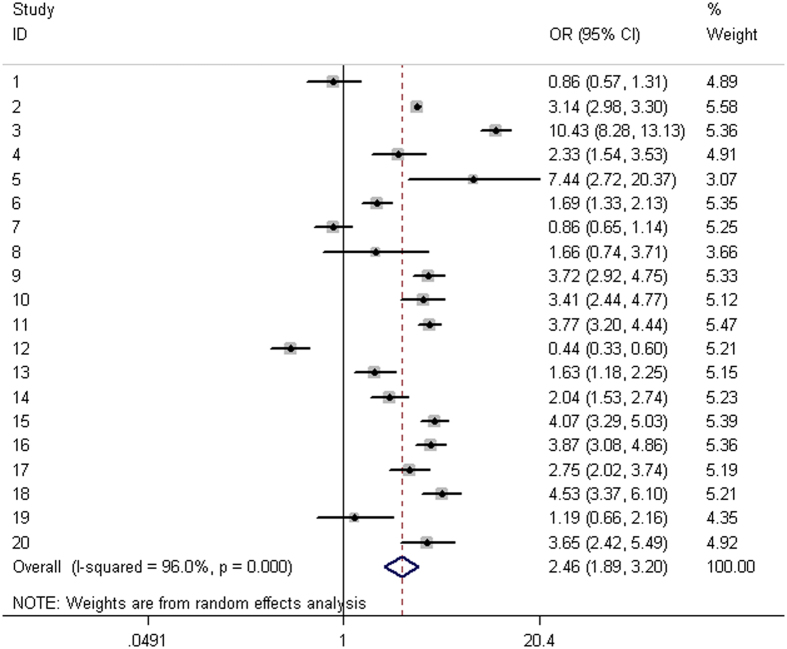
Forest plots of effect estimates for 8q24-rs1447295 polymorphism and prostate cancer risk (AA+AC vs. CC).The size of the squares indicates the relative weight of each study. Weights were derived from random-effects analysis. Bars, 95% confidence interval (CI).